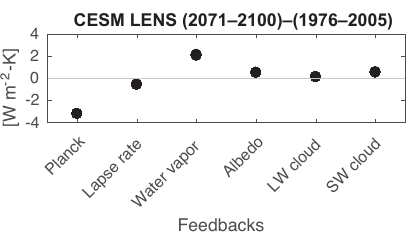
Figure 6. CESM large-ensemble kernels. Feedback calculation for the CESM 40-member large ensemble using the TOA kernels.